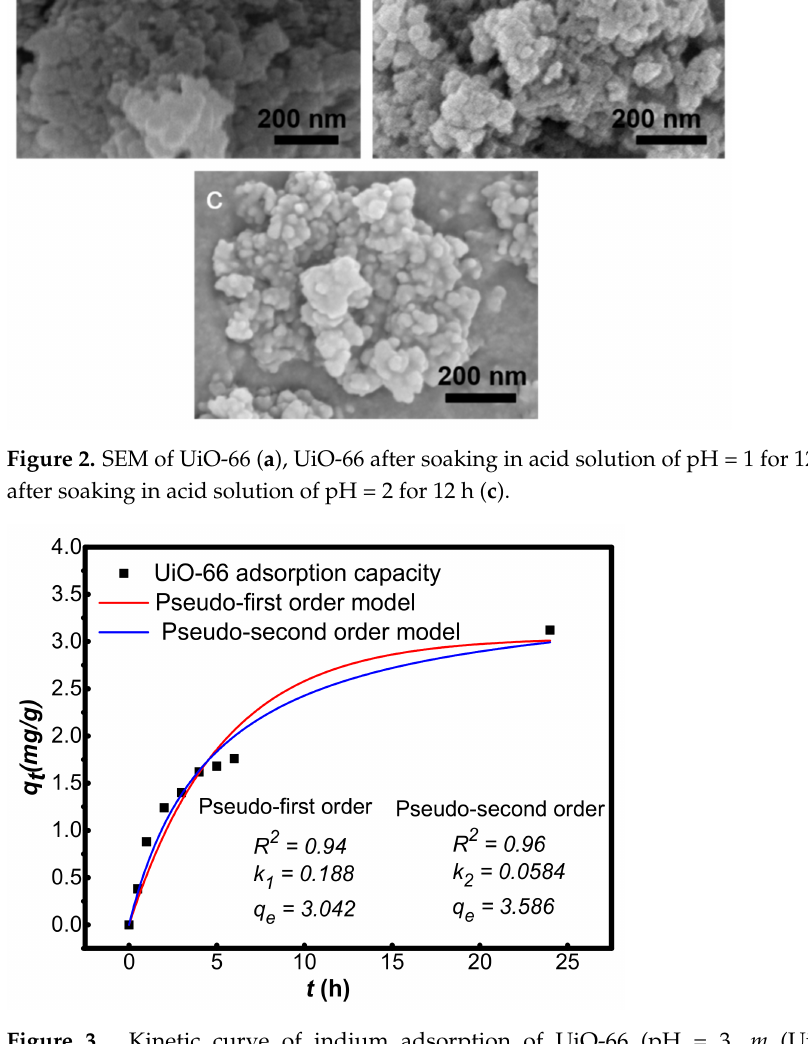
Figure 3. Kinetic curve of indium adsorption of UiO-66 (pH = 3, m (UiO-66) = 200 mg, V (solution) = 400 mL, C 0 = 21.3 ppm and T = 298.15 K). Table 1. Adsorption kinetic model parameters of